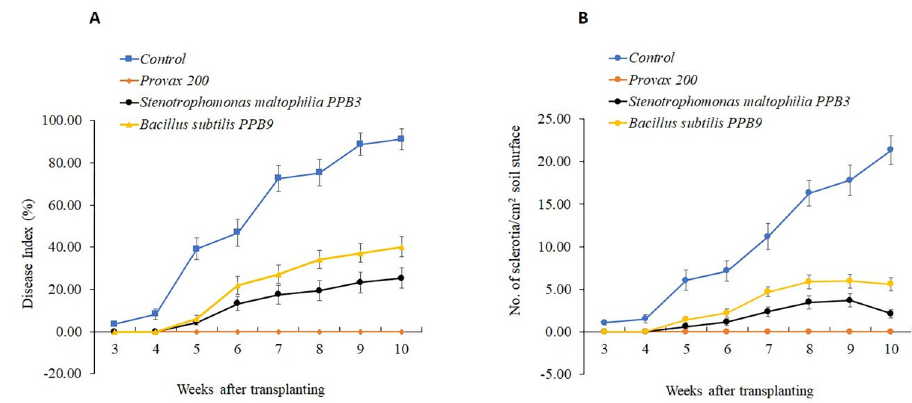
Fig 4. Development of southern blight disease and sclerotia caused by Sclerotium rolfsii in protected and unprotected tomatoes in pots. Seedlings were protected by rhizobacteria by dipping the seedling roots in the cell suspension of Stenotrophomonas maltophilia PPB3 and Bacillus subtilis PPB9 before transplanting in soil containing Sclerotia rolfsii inoculum. Seedlings of unprotected control were dipped in the sterilized water (Control). Soils drenched with Provax 200 (0.3% w/v) at transplanting and one-week post transplanting were considered fungicide- protected checks. Disease developments on each plant were rated every week from 2 weeks after transplanting, where 0 = no symptoms, 1 = < 25% of leaves with symptoms, 2 = 26 to 50% of leaves with symptoms, 3 = 51 to 75% of leaves with symptoms, 4 = 76 to 100% of leaves with symptoms and 5 = plant dead. The disease index was calculated (A). An abundance of sclerotia of S . rolfsii in the soils of protected and unprotected adult potted plants was also calculated (B). In each graph, each point in the line represents the mean value within each treatment category. Vertical lines denote the standard